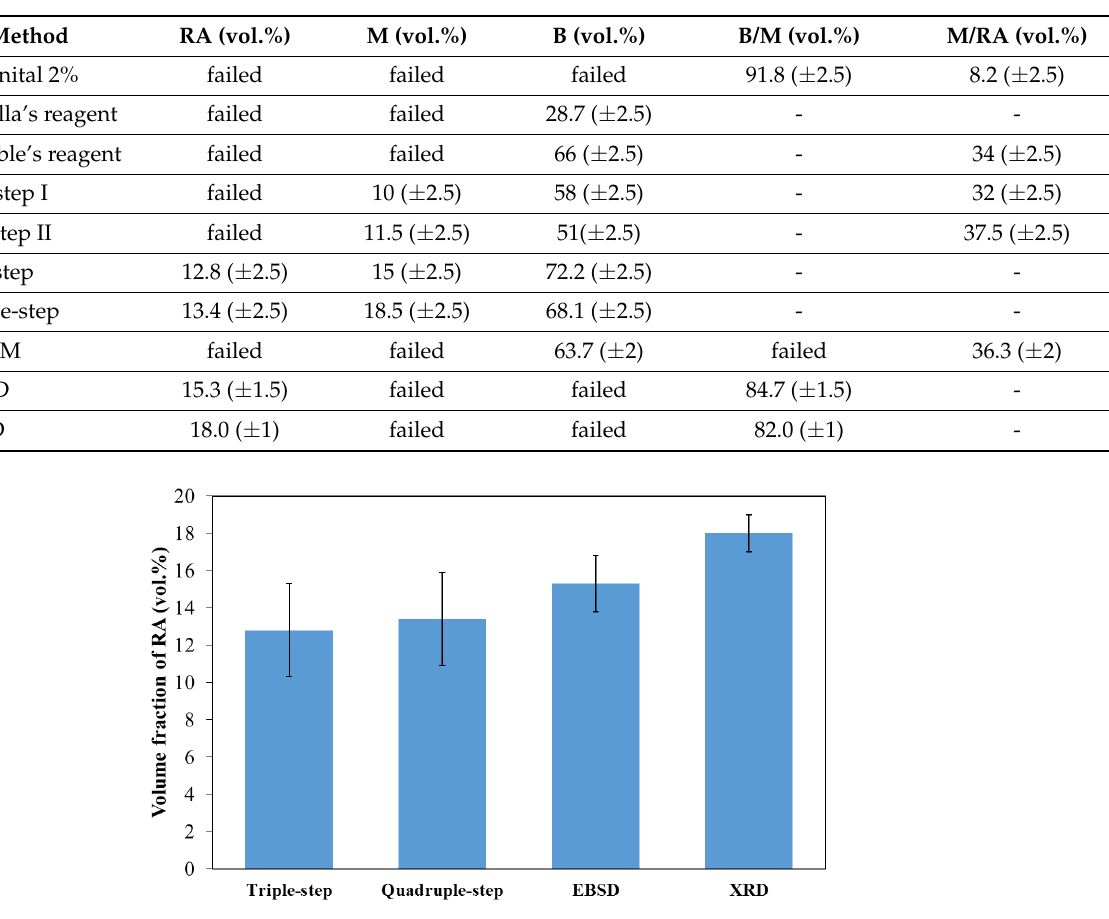
Figure 11. A comparison of the RA volume fractions (vol.%) estimated using different color light metallography methods: triple-step (12.8%) and quadruple-step (13.4%). The measurements made using the EBSD (15.3%) and XRD (18%) techniques are also included in the figure for comparison.